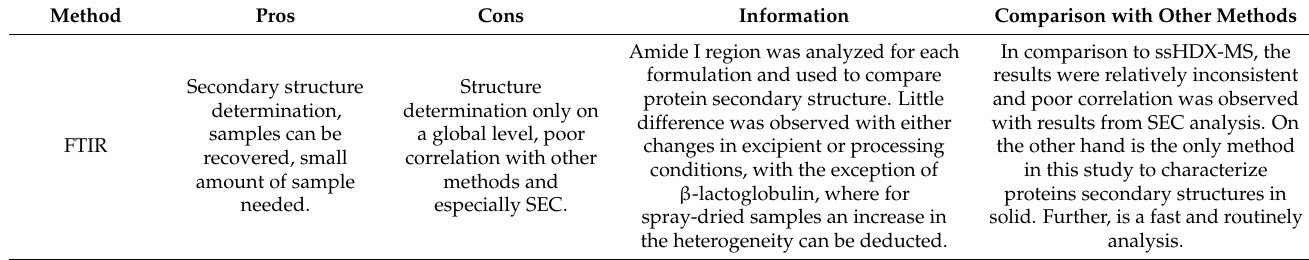
Table 4. Comparison of different methods used for analysis of the same or similar protein